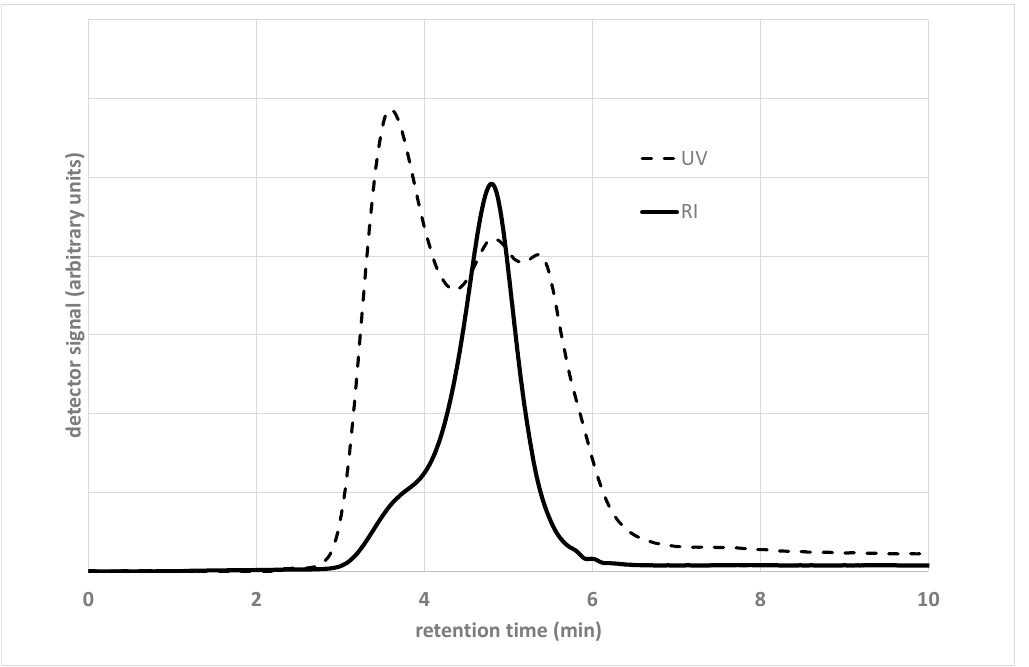
Figure 2. Distribution of retention time for the same sample of a base bitumen measured with UV and RI detectors. Details on the material are given in [16,17].